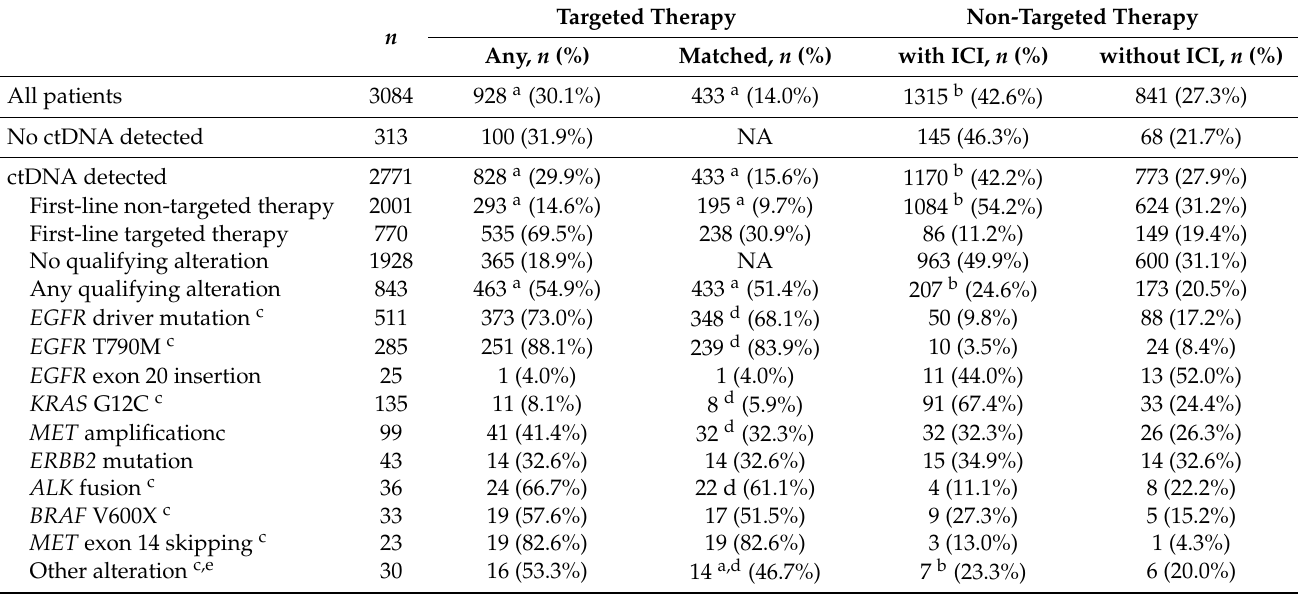
Table 4. Second-line treatments administered.